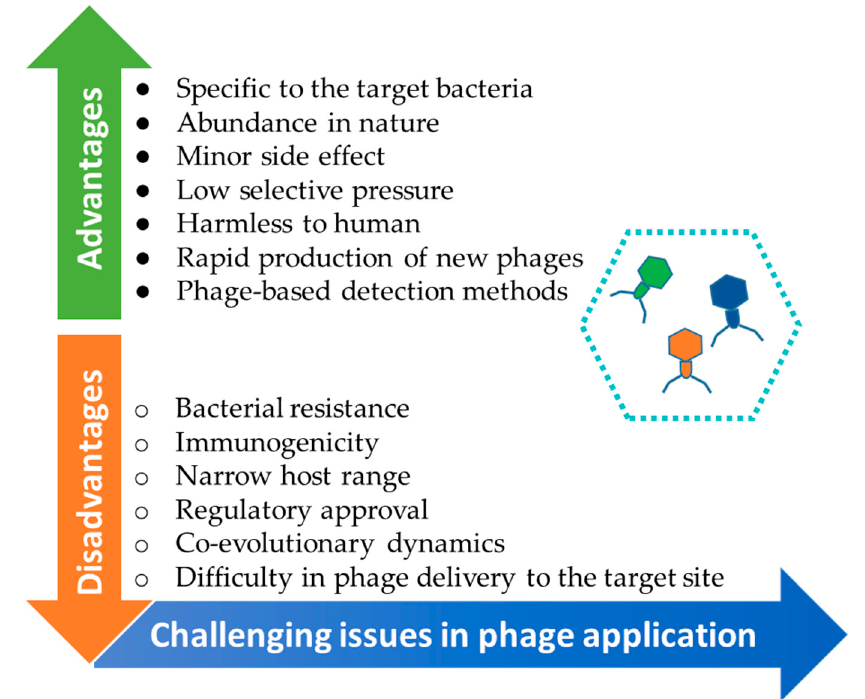
Figure 1. Advantages and disadvantages of using bacteriophages for the treatment of Salmonella [19]. Table 1. Lytic spectrum of bacteriophages against Salmonella and other foodborne pathogens.